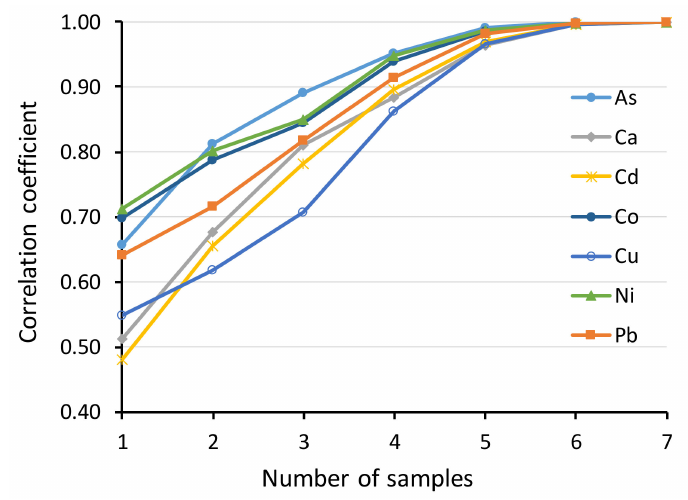
Figure 1. Pearson correlation coe ffi cients between the brood mean element concentrations and the mean concentrations for increasing numbers of randomly chosen nestlings within brood. N =